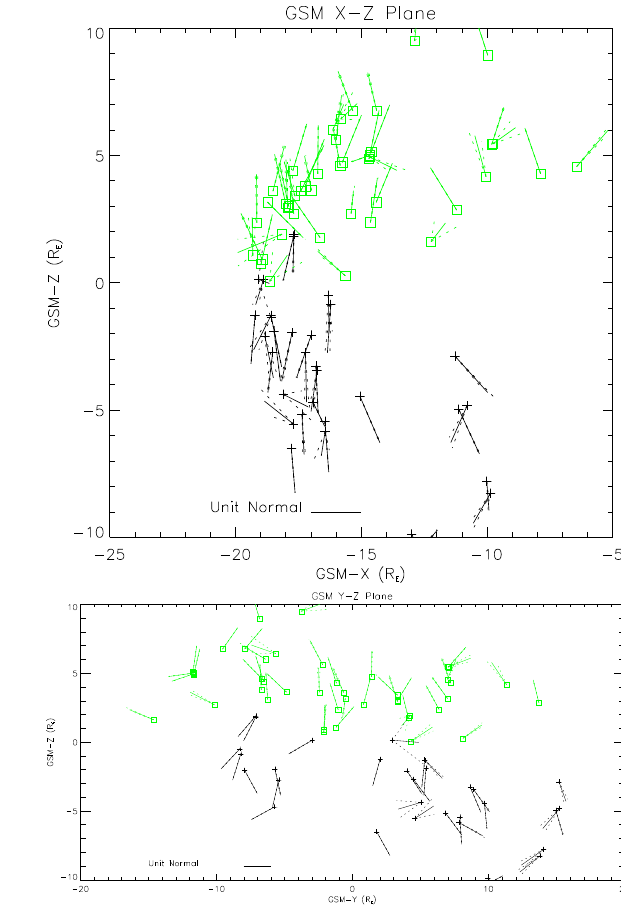
Fig. 12. For each passage of the spacecraft from the lobe into the plasma sheet on the GSM–YZ and GSM–XY planes, the projection of the lobe – plasma sheet boundary normal vector on that plane is shown, together with an estimate of the error associated with the spacecraft spin (dotted line). A unit normal entirely in that plane is shown for reference. In the north lobe the trend is for expan- sion normals to point away from neutral sheet and have a negative GSM–Y component. In the south lobe there are two trends: in the pre-midnight region the vectors have a positive GSM–Y component and in the post-midnight region they have a negative GSM–Y com-